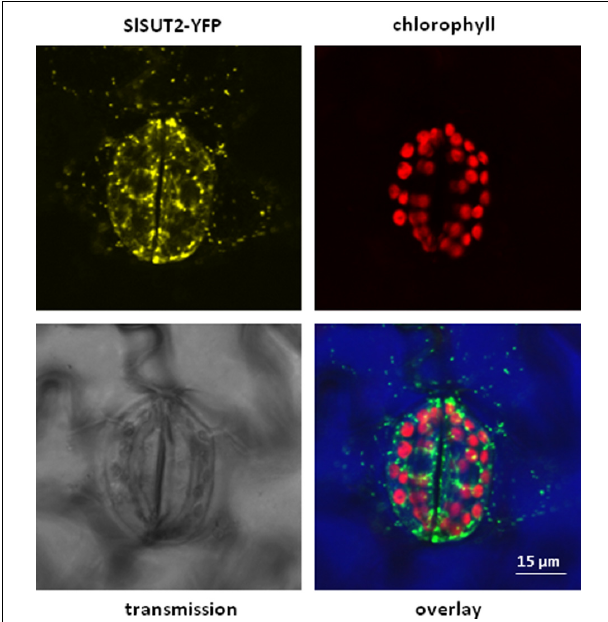
FIGURE 1 | Overlay picture showing subcellular distribution of a SlSUT2-YFP construct expressed under control of the constitutive CaMV 35S promoter in the vector pK7YWG2.0 (Karimi etal., 2002) in stably transformed tobacco plants ( Nicotiana tabacum ). SlSUT2-YFP fluorescence is mainly retained in intracellular structures, a possible argument for its non-functionality at the plasma membrane. Contrast of the overlay picture was enhanced by choosing the RGB mode leading to color modification.YFP fluorescence is therefore shown in green, chlorophyll autofluorescence is shown in red. Color of the transmission image is shown in